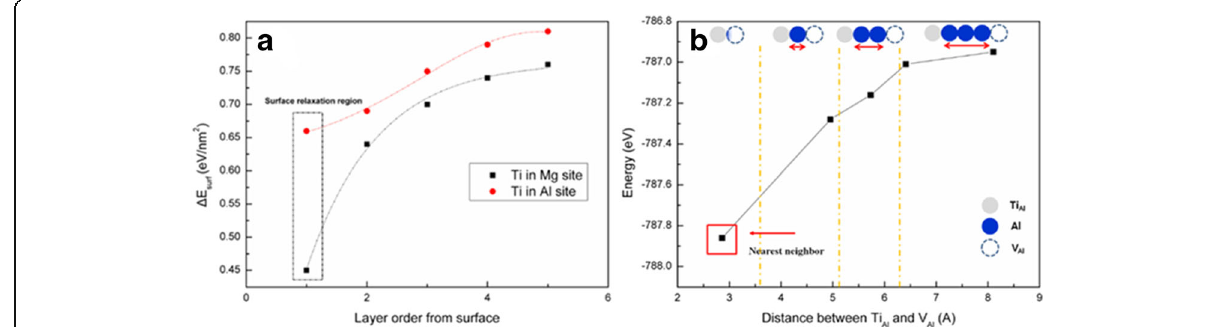
Fig. 4 a Stabilities of Ti in Mg or Al vacancy site on the surface of MgAl 2 O 4 : the red circle shows surface energy of Ti in Al site and the black dot is that of Ti in Mg site and b the binding energy of defect associates, Ti Al· – V Al ′′′ as a function of